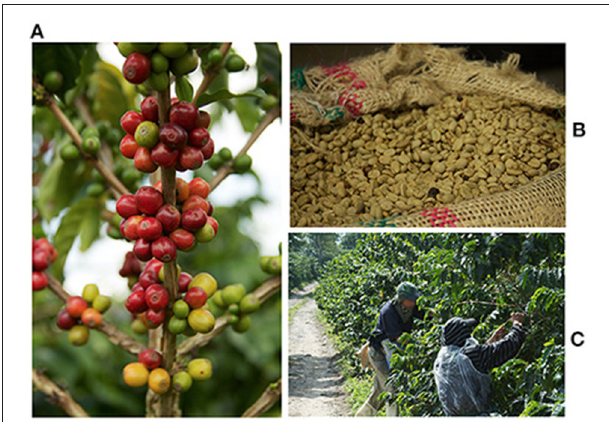
FIGURE 3 | Coffee (Coffea arabica and C. canephora). (A) Coffee (C. arabica) berries. (B) Roasted coffee beans ready to be husked. (C) Plantation workers picking coffee berries in Colombia. Source: M. Savage. CC BY